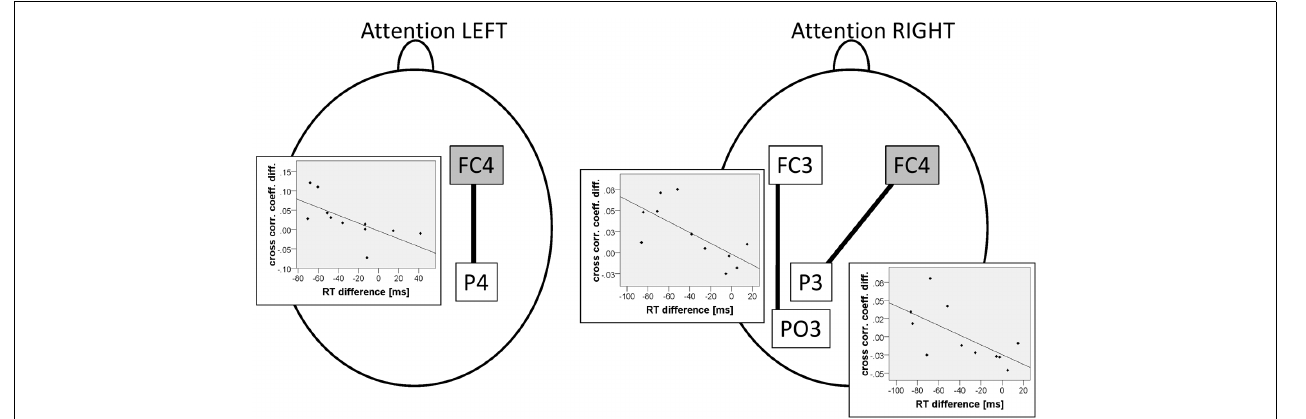
vertex rTMS show larger response time increase. Note that in this effect there are always posterior sites involved that are located contralateral to the attended visual